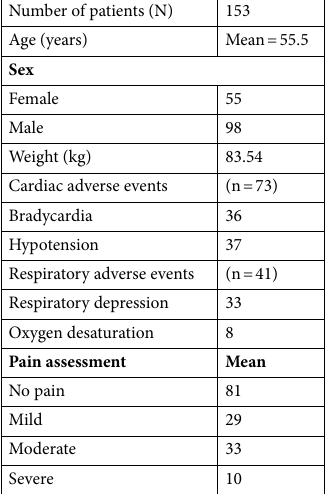
Table 1. Demographic data and adverse events in the subjects who received